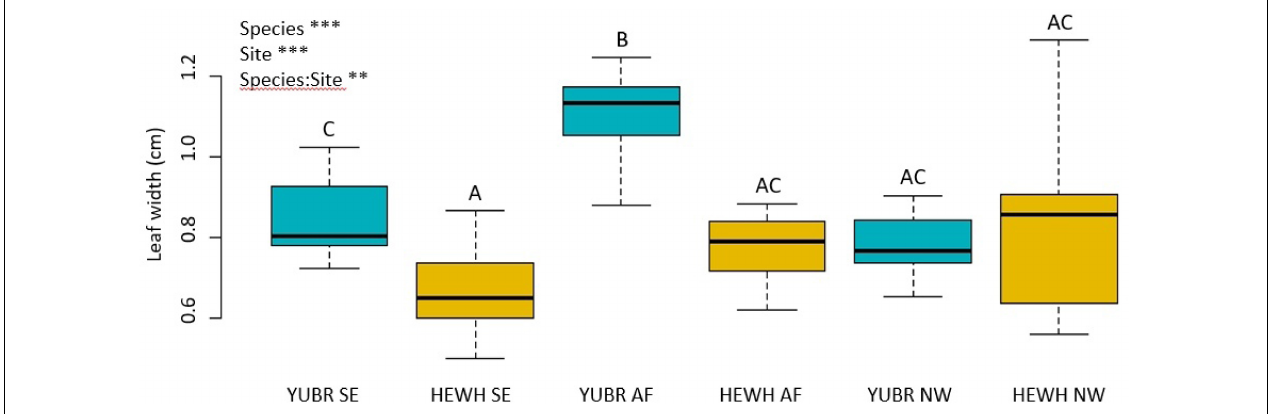
FIGURE 5 | Leaf width varied across species, sites, and had significant species-site interactions. Different letters denote statistically significant differences ( p < 0.05) by single-factor ANOVA followed by a Tukey-Kramer post hoc test. YUBR = Y. brevifolia ; HEWH = H. whipplei ; SE, south-eastern slope; AF, alluvial fan; NW, north-western slope. n = 9–11 leaves per species per site. *** p < 0.001; ** p < 0.01.